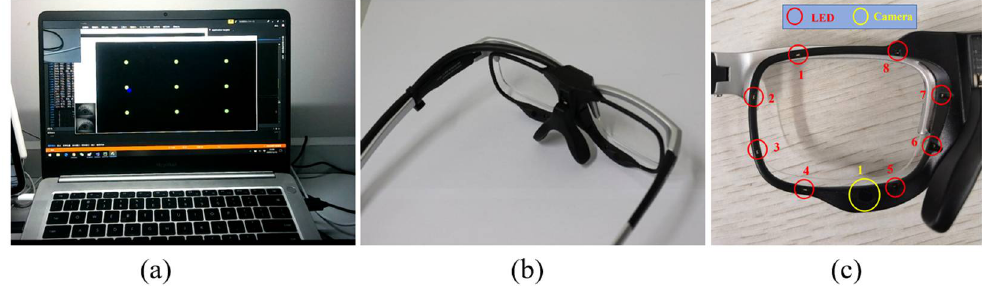
Figure 5. Equipment of gaze tracking system. ( a ) Laptop and tracking program. ( b ) aSee Glasses (Beijing 7INVENSUN Information Technology Co. Ltd, Beijing, China). ( c ) Schematic diagram of infrared LED lights and eye